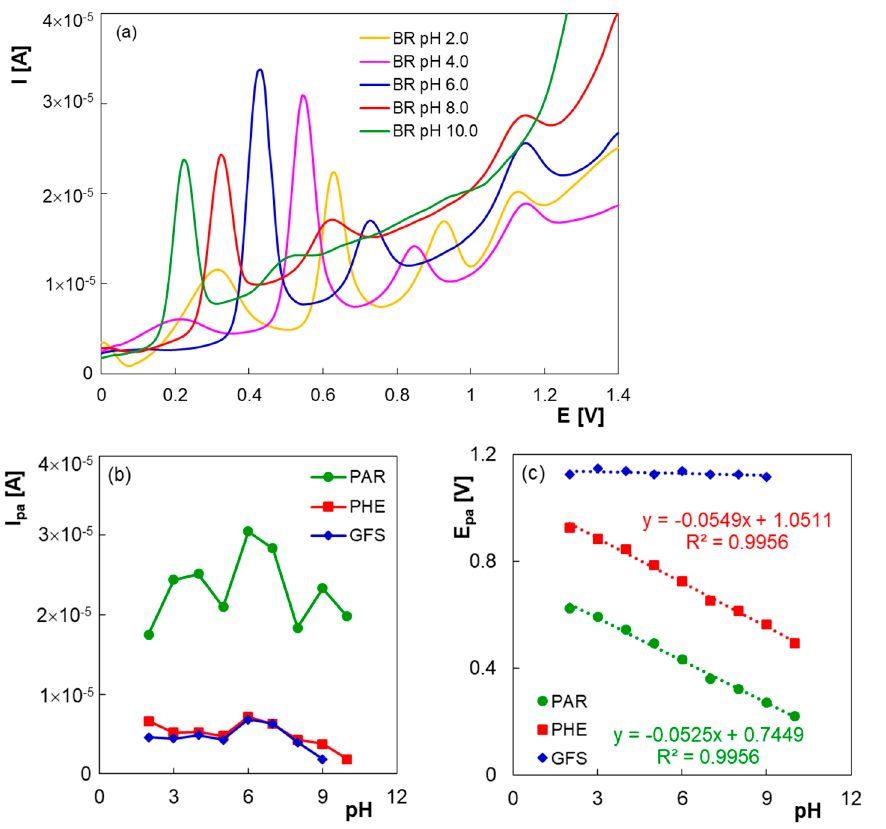
Figure 2. Differential pulse voltammograms (selection) of a mixture of 2.00 × 10 − 5 M PAR, 2.00 × 10 − 5 M PHE and 2.00 × 10 − 5 M GFS at PGE* in BR buffer solutions with different pH values ( a ); graphical representation of I pa vs. pH ( b ); graphical representation of E pa vs. pH ( c ).